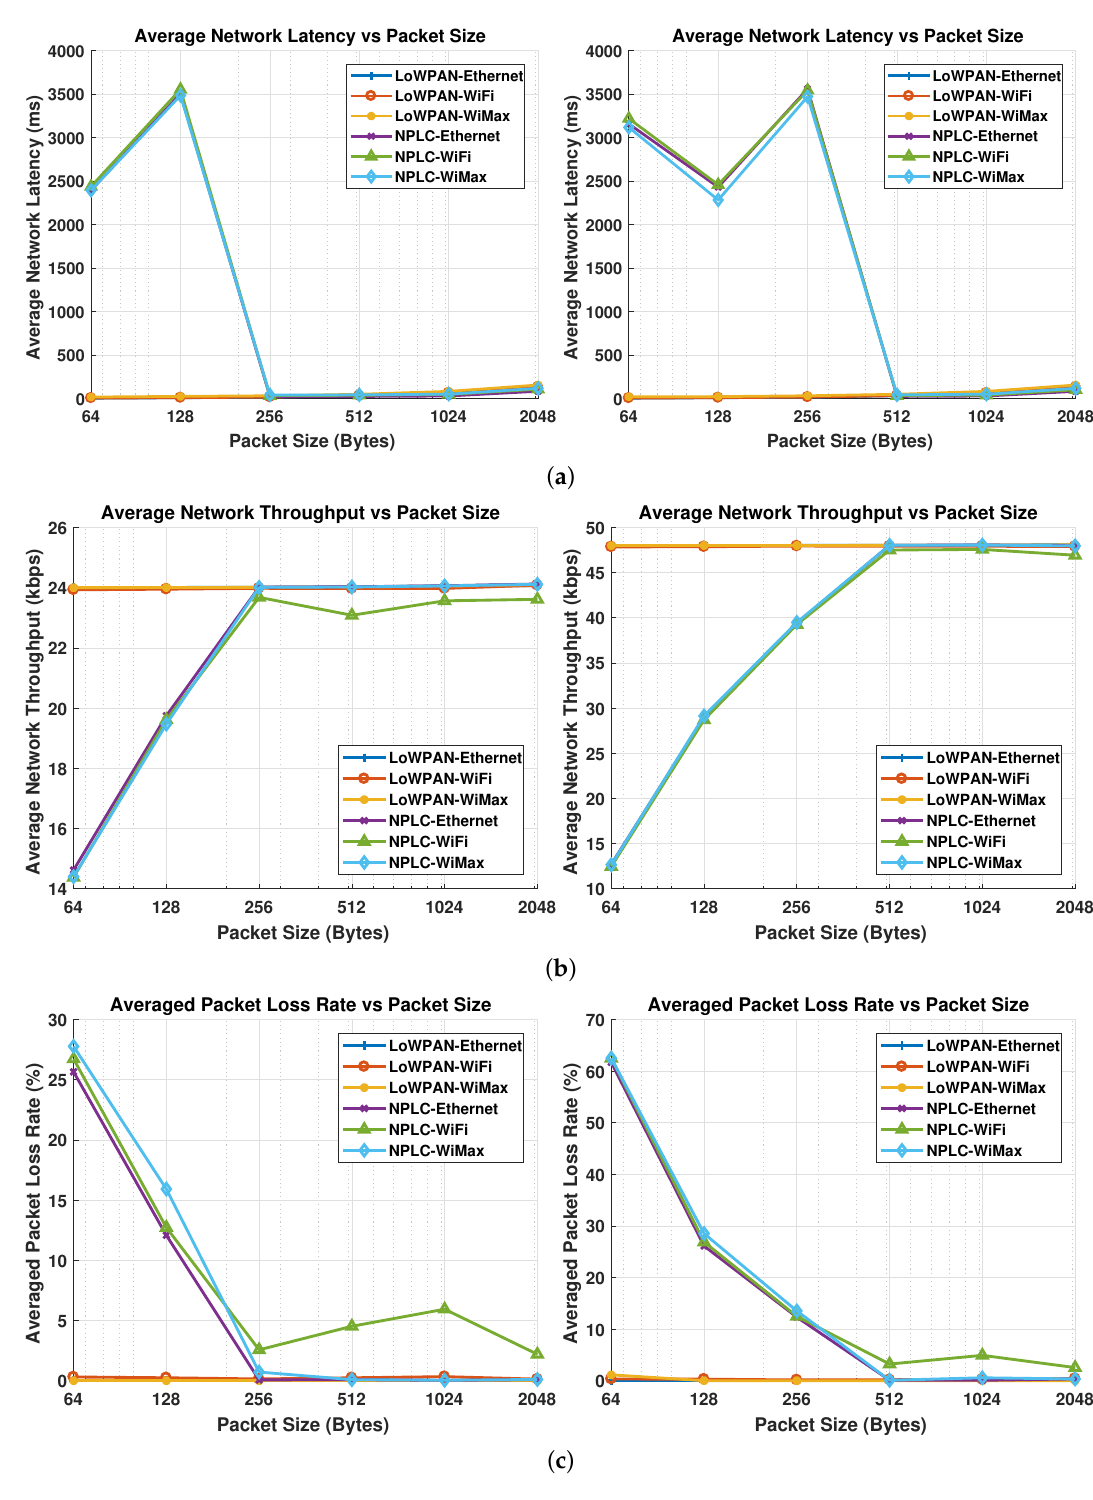
Figure 5. Performance comparison of six hybrid communication designers in terms of UDP packet size and data rate–NPLC. ( a ) Latency for data rate 24–48 Kbps; ( b ) Throughput for data rate 24–48 Kbps; ( c ) Packet Loss Rate for data rate 24–48